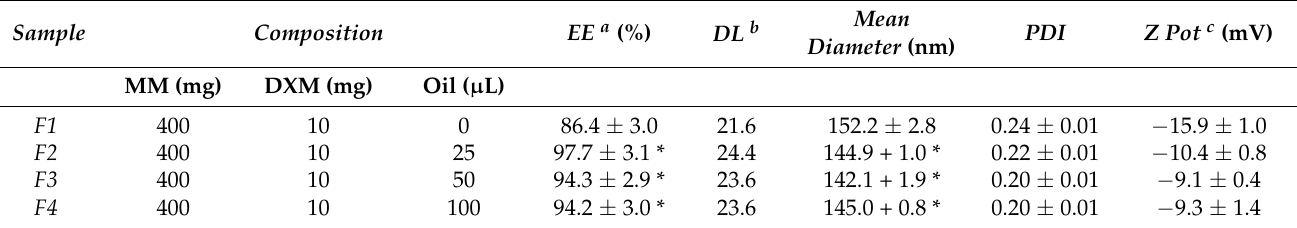
Table 1. Characteristics of NLC formulations.